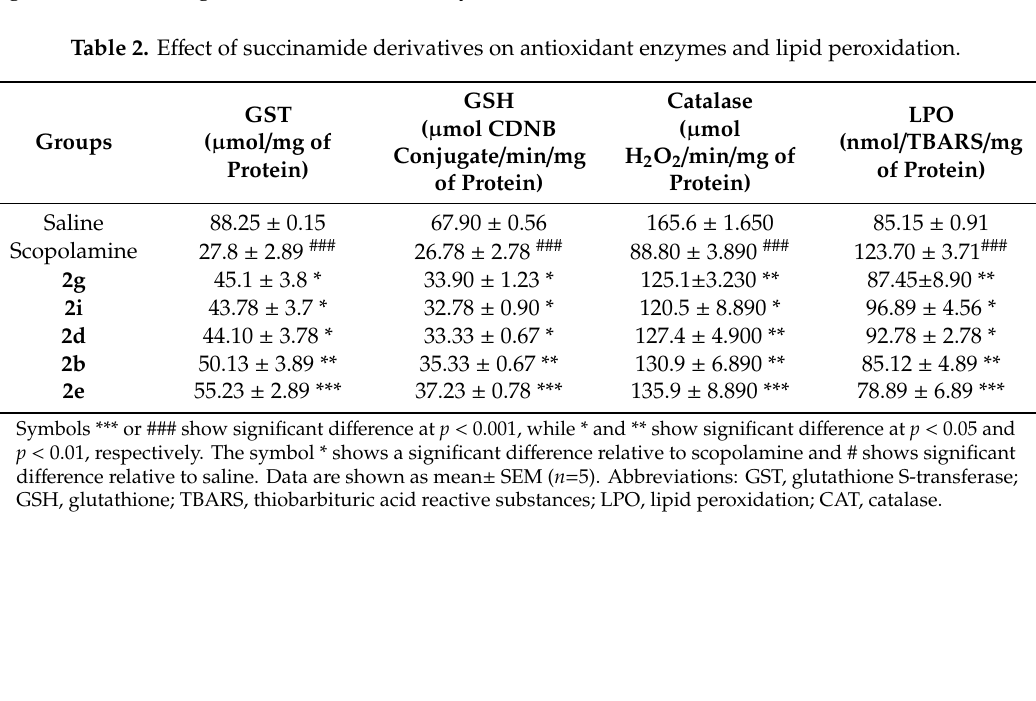
Table 2. E ff ect of succinamide derivatives on antioxidant enzymes and lipid peroxidation. Table 2. Effect of succinamide derivatives on antioxidant enzymes and lipid peroxidation. GSH GST Groups Groups (µmol/mg of Protein) Saline Scopolamine